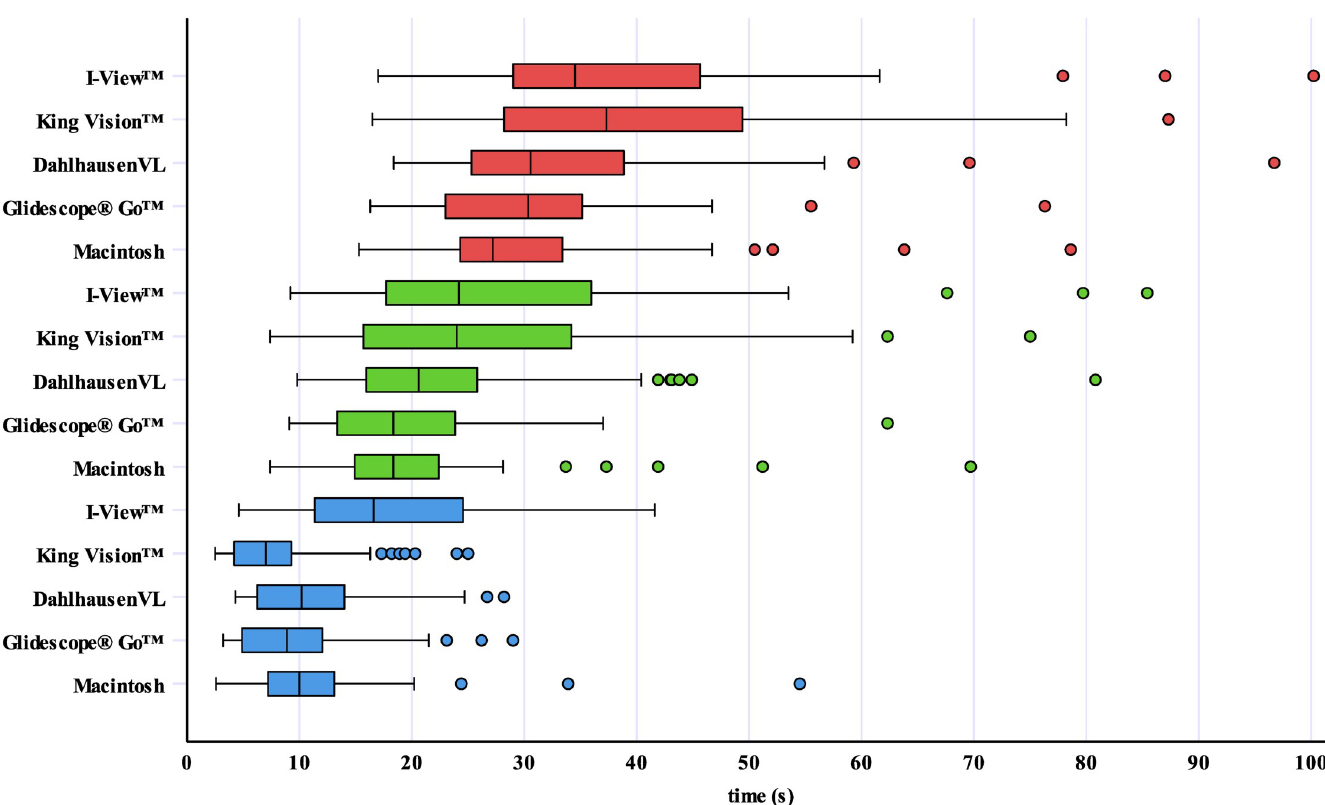
Fig 4. Recorded intubation times of the paramedics with little previous experience in conventional and even less previous experience in video laryngoscopy. Data are presented as boxplots that indicate the median (middle line), the 25 th and the 75 th percentile (box boundaries), the upper and lower limits within 1.5 times inter- quartile range (whiskers) and outliers (circles). The blue boxplots represent the “time to vocal cords”, the green boxplots represent the “time to intubate” and the red boxplots represent the “time to